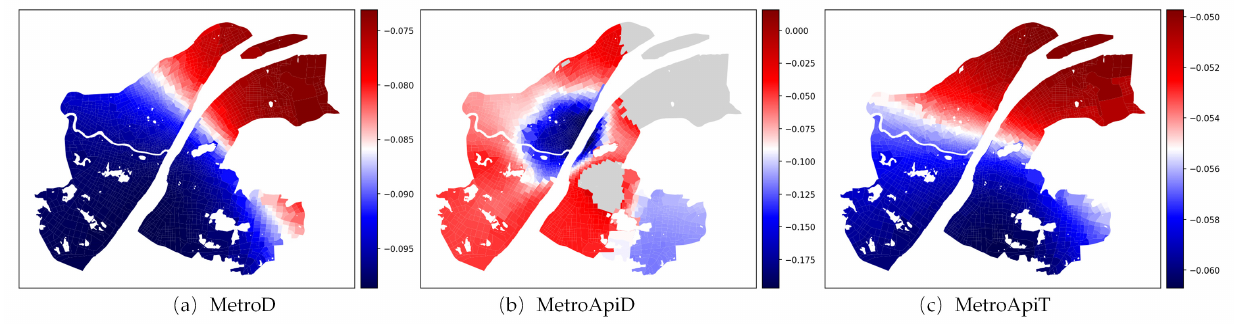
Figure 10. Multiscale effect of metro station accessibility. ( a ) Distance to nearest metro station, ( b ) Travel distance to metro stations calculated by Baidu Map API, ( c ) Travel time to metro stations calculated by Baidu Map API.